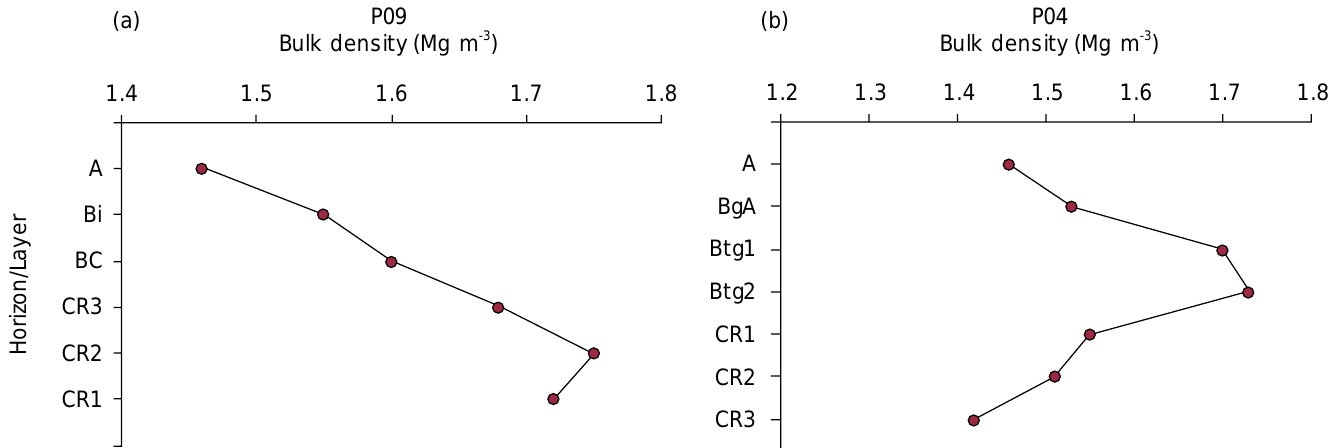
Figure 4. Representative of the group of profiles where the density increases at the soil-saprolite boundary (a) and profiles where the density decreases at the soil-saprolite boundary (b).